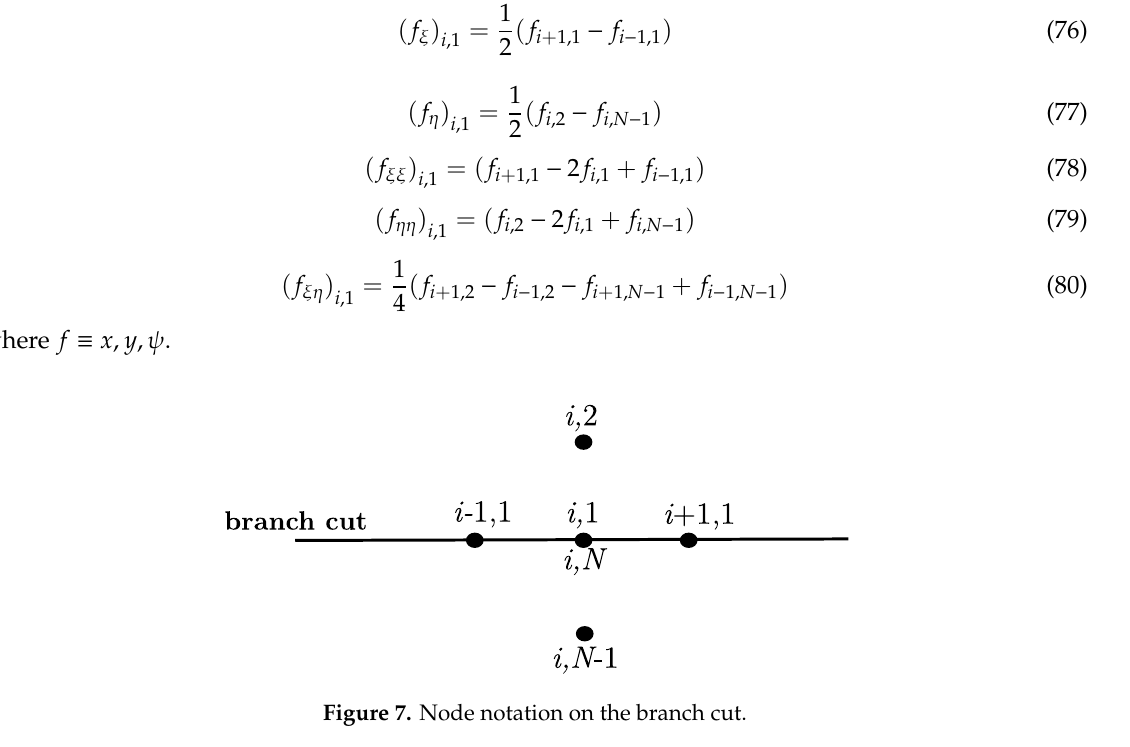
Figure 7. Node notation on the branch cut.